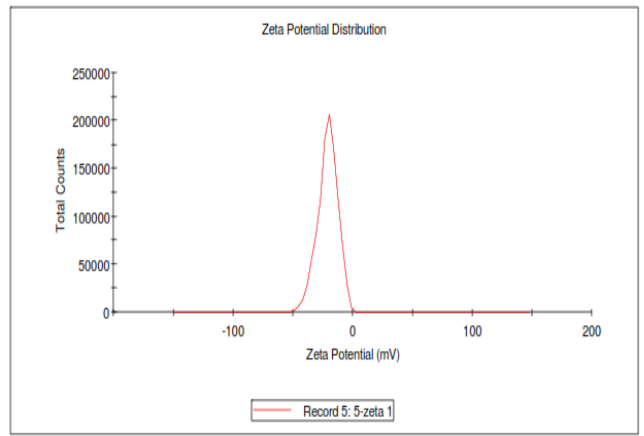
Figure 4. Zeta potential of PTAgNPs.